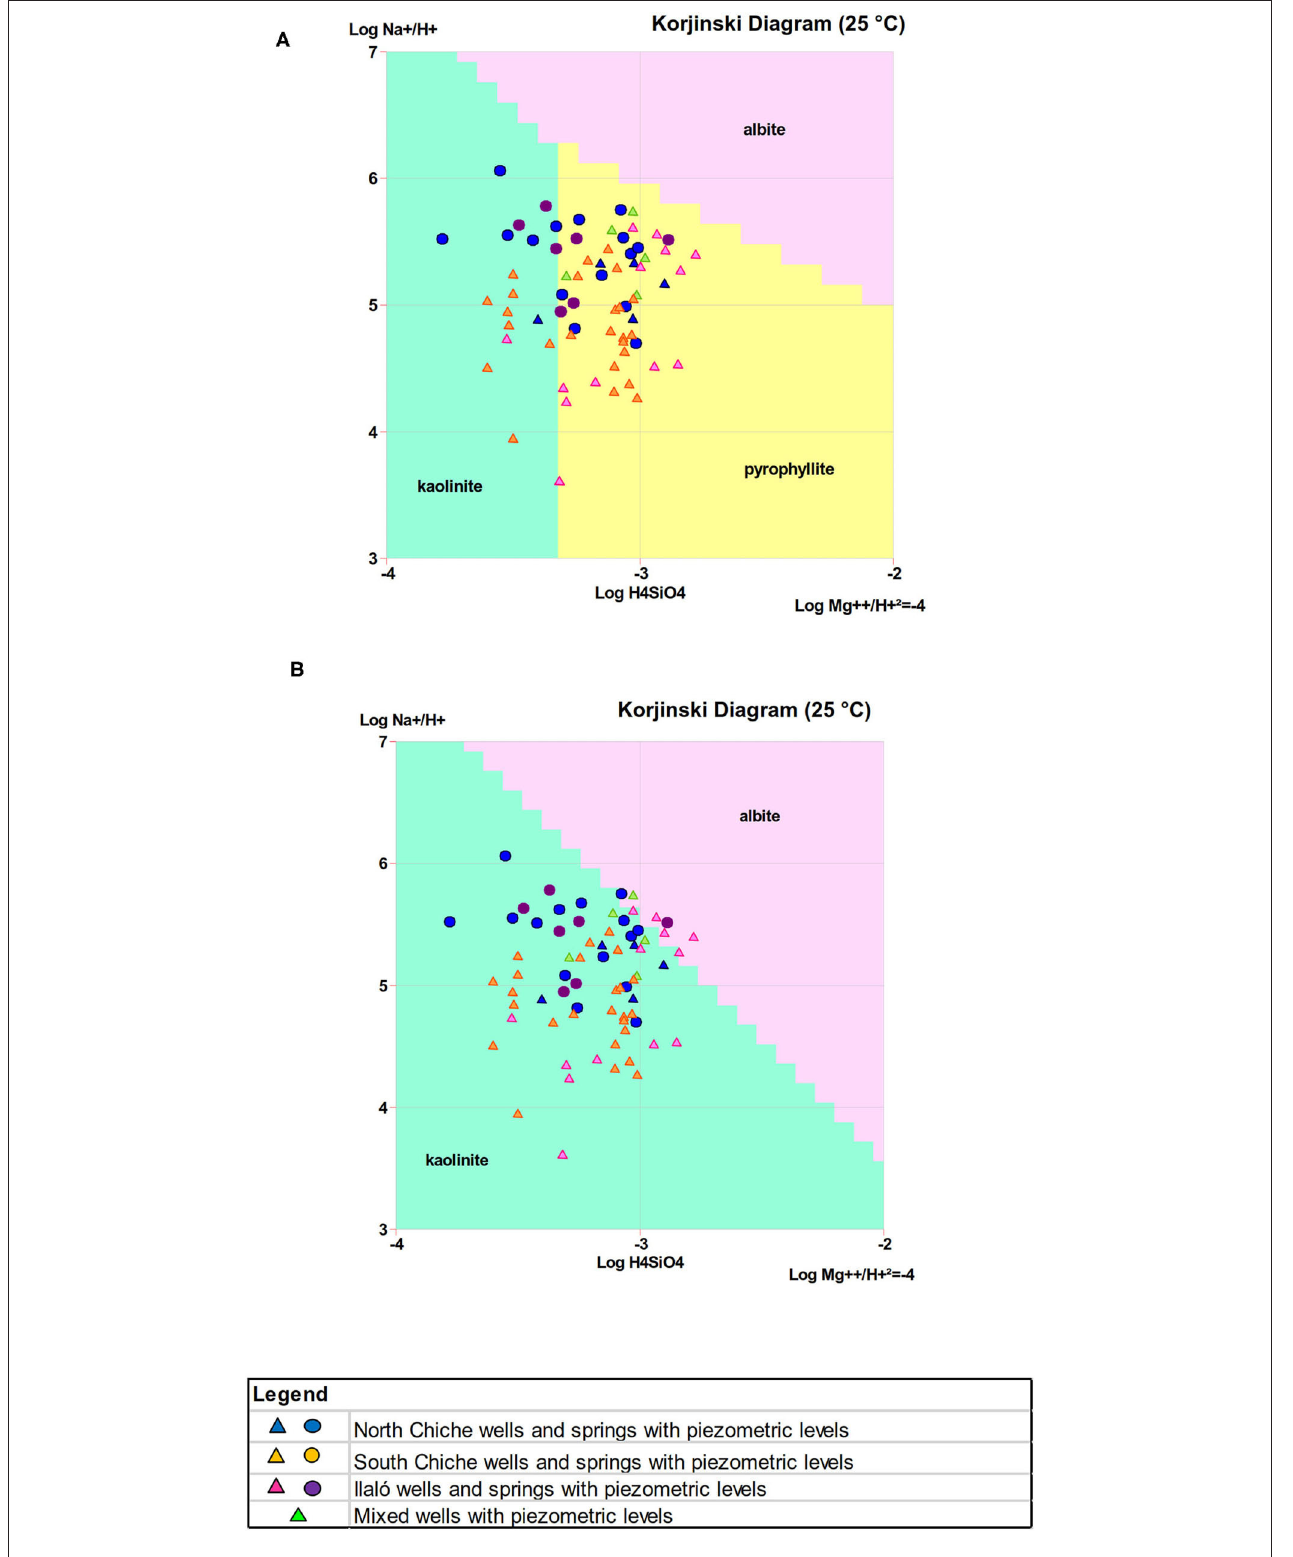
FIGURE 9 | Korjinski diagram at 25 ◦ C or alumino-silicate activity diagram (A) before equilibrium and, (B) after equilibrium when pyrophillite is not stable.